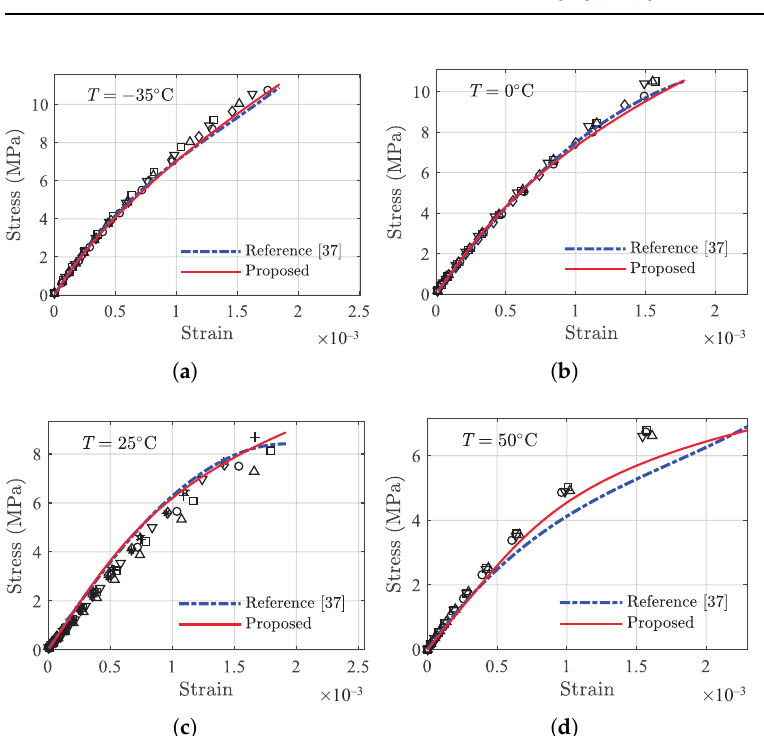
Figure 16. Comparison of the viscoelastic model and the proposed model at validation tempera- tures under tension. The discrete markers represent testing data. ( a ) − 35 ◦ C, ( b ) 0 ◦ C, ( c ) 25 ◦ C, and ( d ) 50 ◦